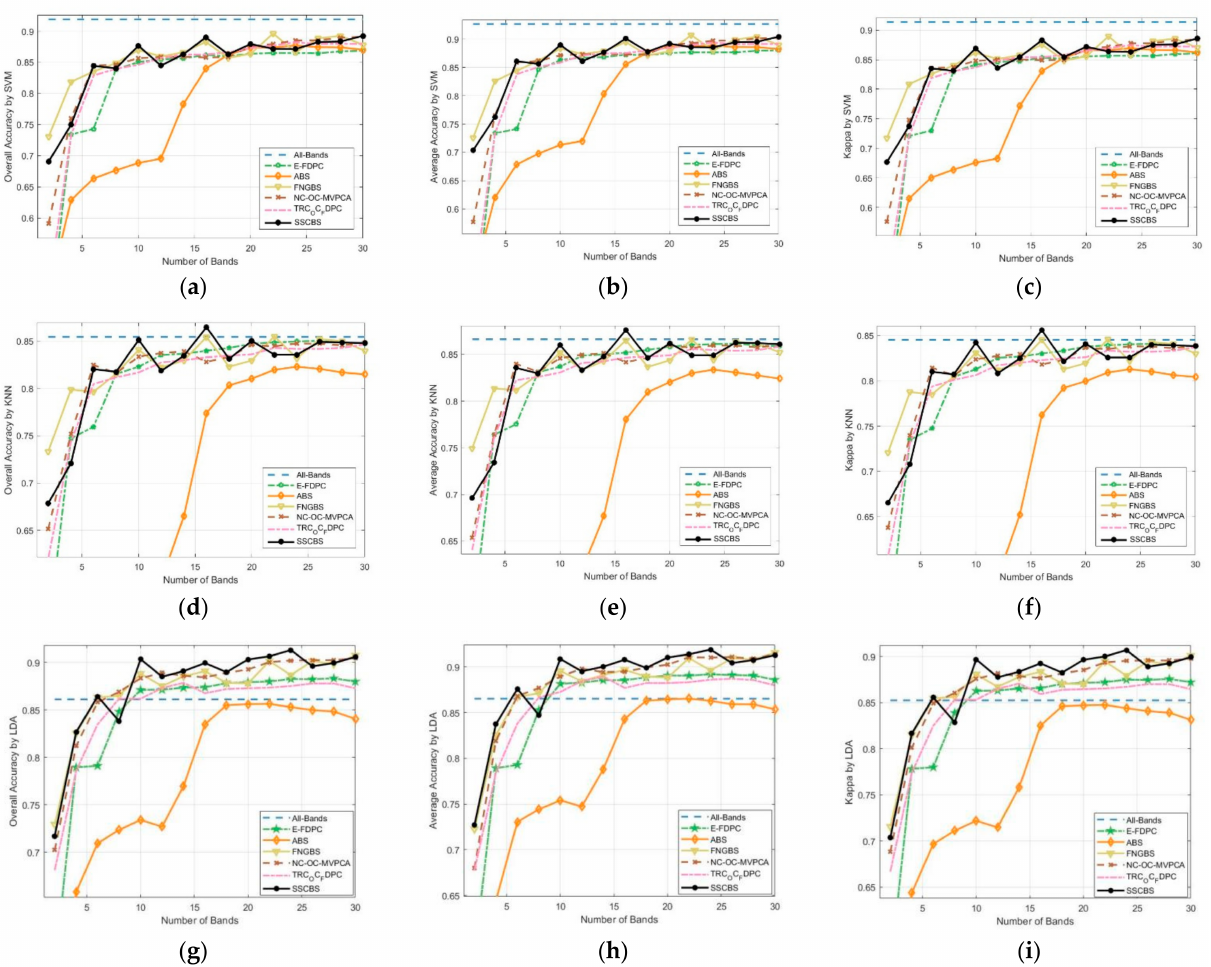
Figure 13. Classification results on Botswana data set. ( a – i ) are OA, AA and Kappa Results by SVM, KNN and LDA